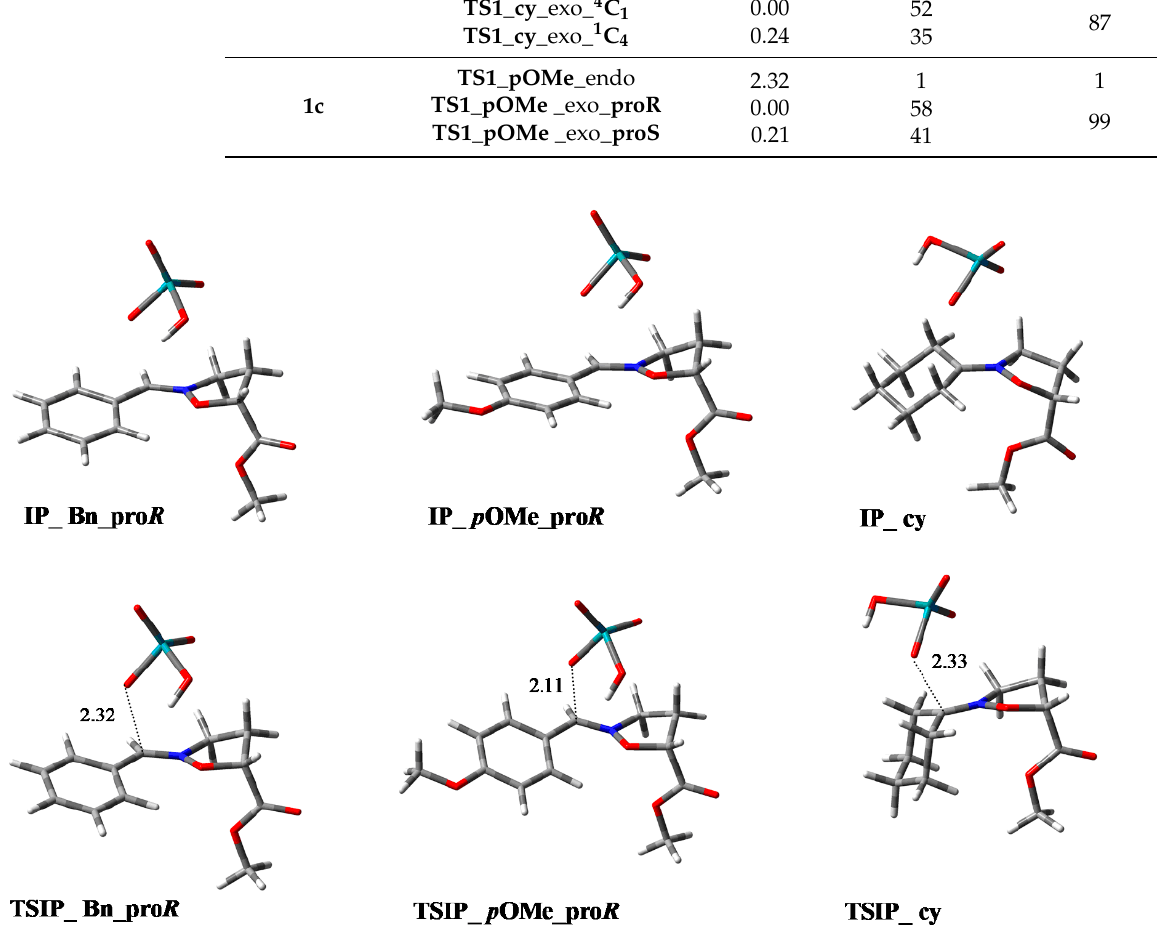
Figure 2. Three-dimensional plots of the transition states TS1 for the endo and exo pathways of compounds 1a – c . Displacement vectors for TS imaginary frequencies are shown as dotted lines and distances are reported in angstroms.